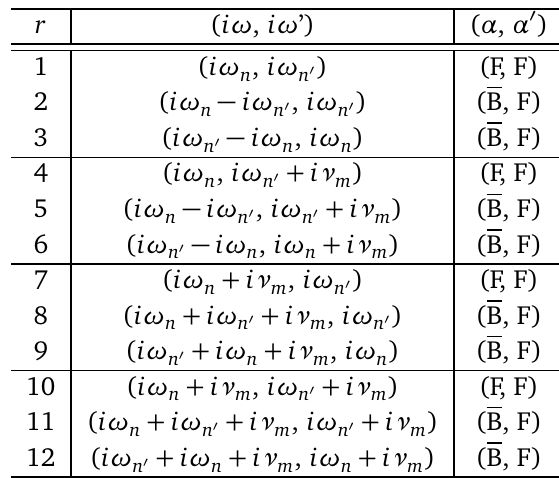
Table 2: 12 different notations of Matsubara frequencies and statistics for four-point Green’s functions in the particle-hole notation at a fixed bosonic